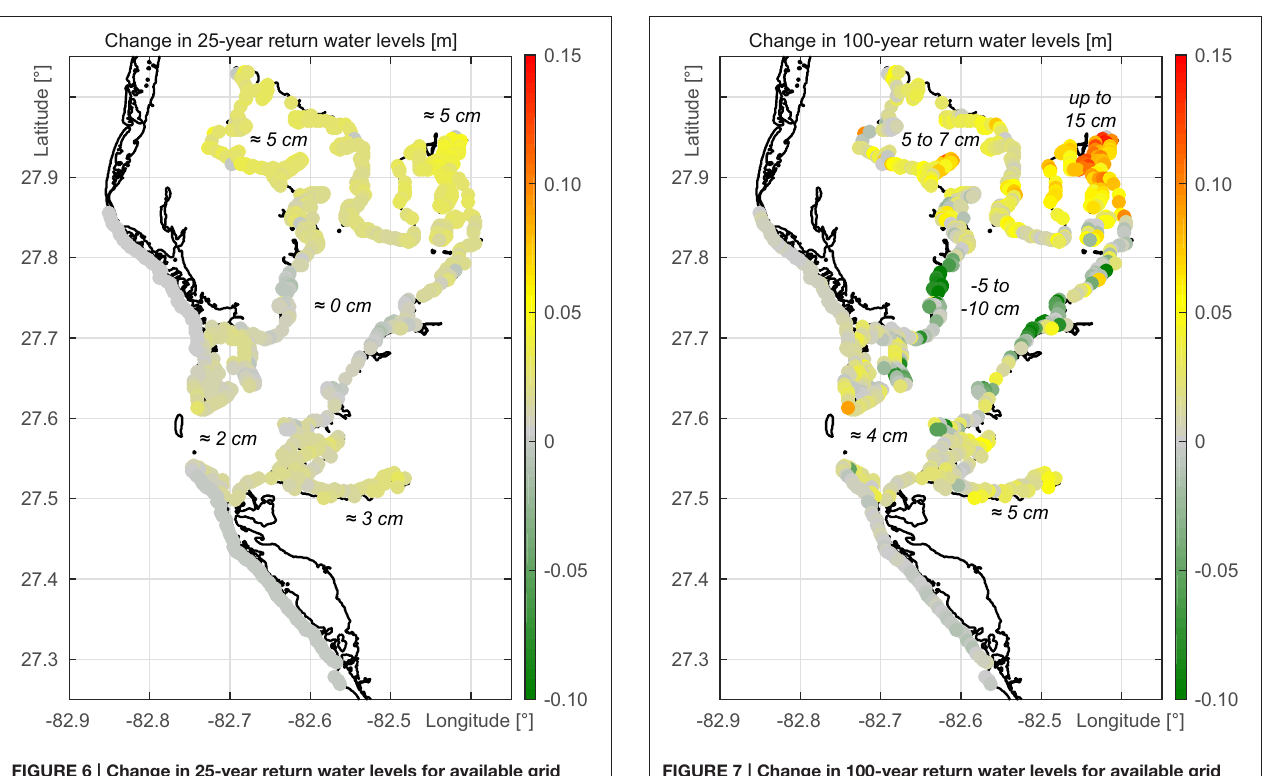
of a few centimeters along the center line of the estuary and the northern parts of Tampa Bay are not affected at